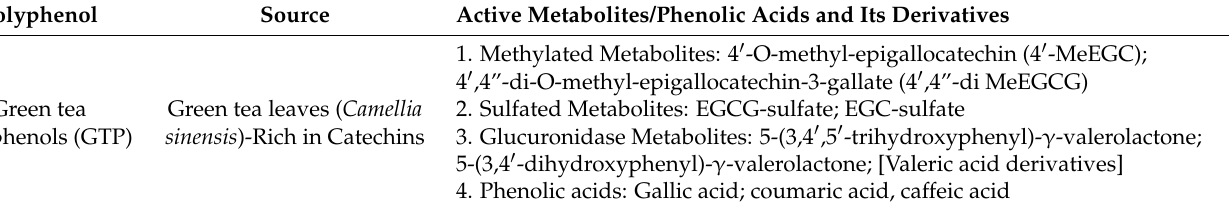
Table 1. List of popular polyphenols and their major metabolites. Active Metabolites/Phenolic Acids and Its